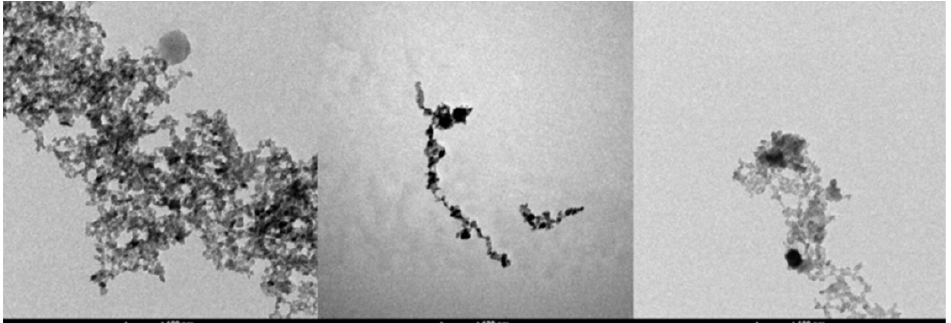
Figure 8. TEM image of CuO − TiO 2 hybrid nanofluid.